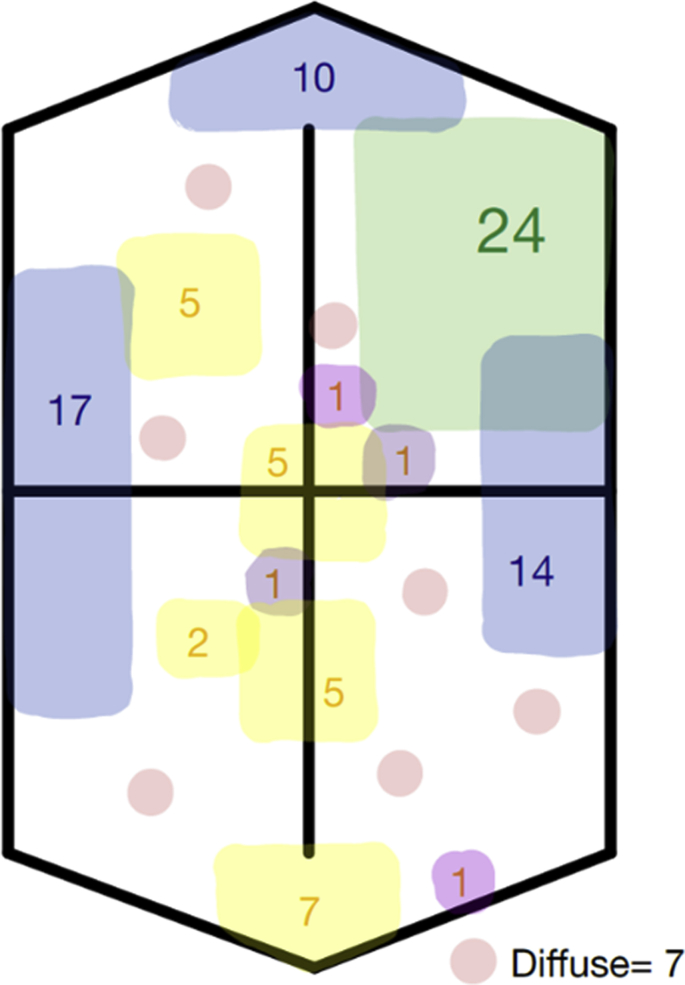
Diagrammatic representation for the various locations of internal calcifications (by percentage, %) seen within the present cohort (n = 42).